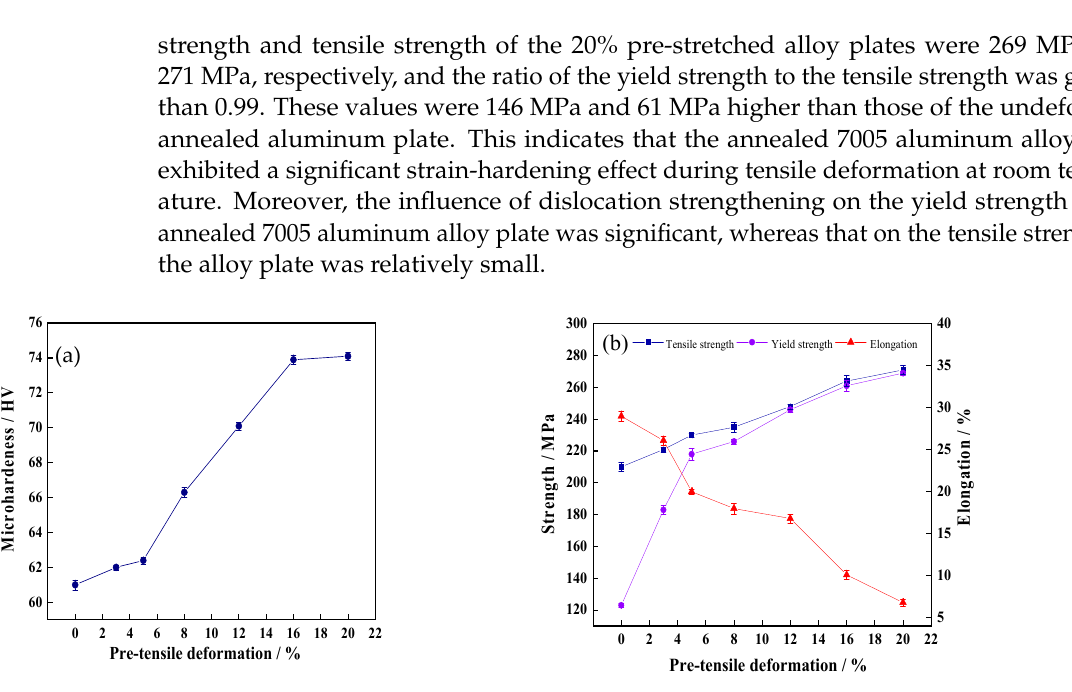
Figure 7. Mechanical properties of annealed 7005 aluminum alloy plates subjected to different pre-tensile deformations: ( a ) micro-hardness, ( b ) yield strength, tensile strength, and elongation.